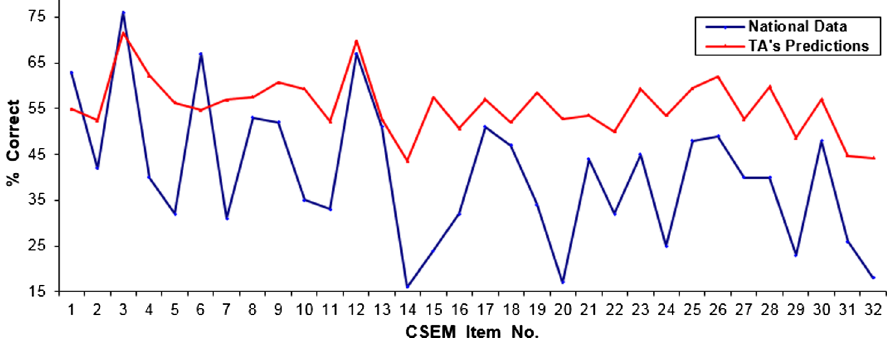
FIG. 13. Comparison of the percentages of correct answers predicted by TAs with algebra-based students ’ actual performance after traditional instruction as obtained from Ref. [23]. Standard deviations range between 17.7 and 24.6 and are not shown for